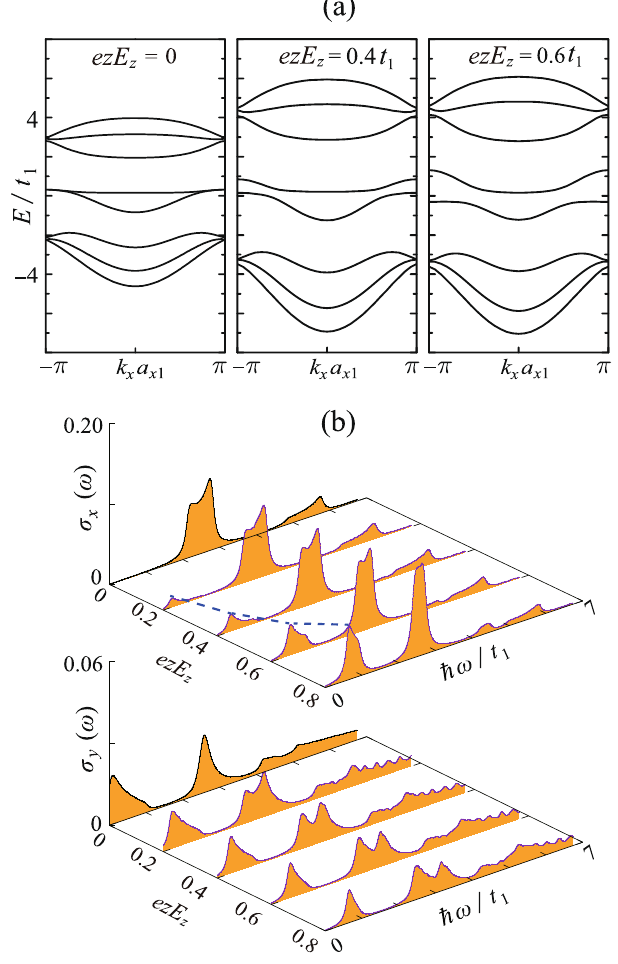
Figure 6. Same as Fig. 4, but for the case of varying the z -direction electric fields. The growth of the low-lying x -polarized absorption peak with increasing E z is illustrated by the blue dashed curve in ( b ).